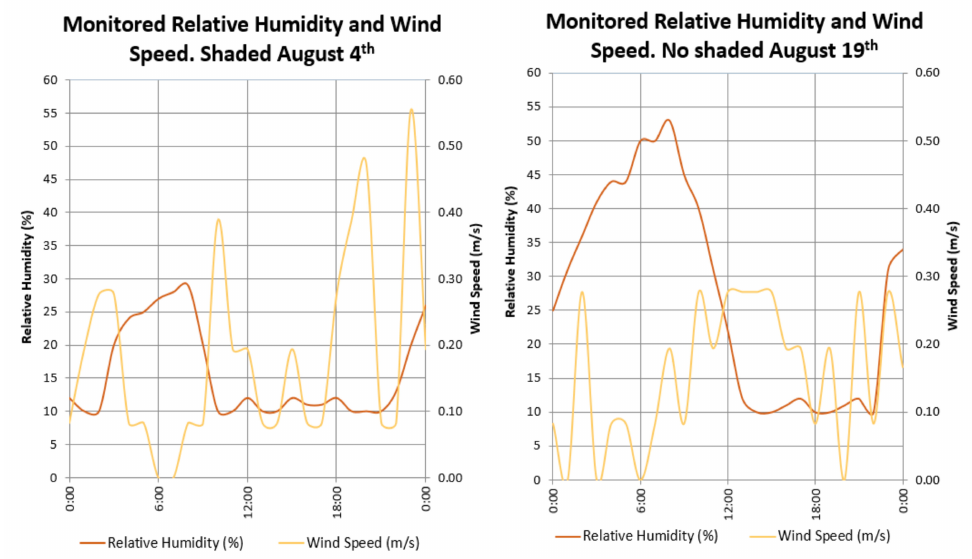
Figure 4. Monitored outdoor relative humidity and wind speed on the selected days.